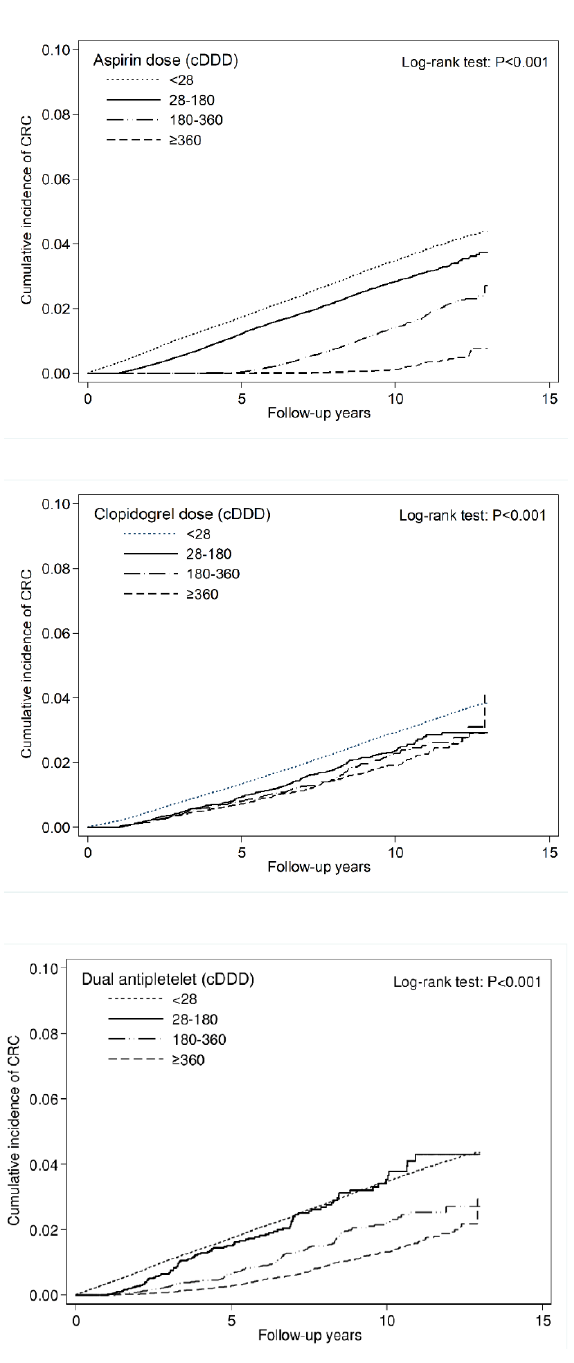
Figure 2. Cumulative incidence curve of CRC stratified by cumulative doses.